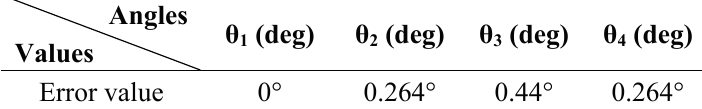
Table 2. Angle errors of 4 joints: test point (173, − 101,